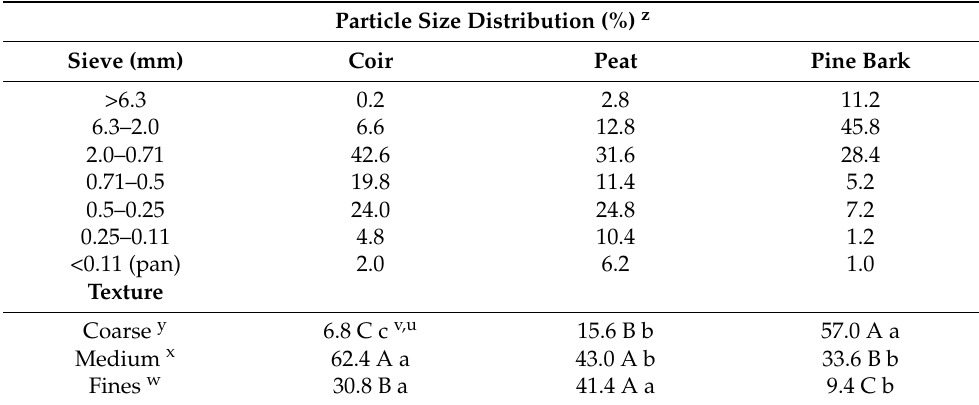
Table 1. Particle size distribution of three traditional greenhouse substrate